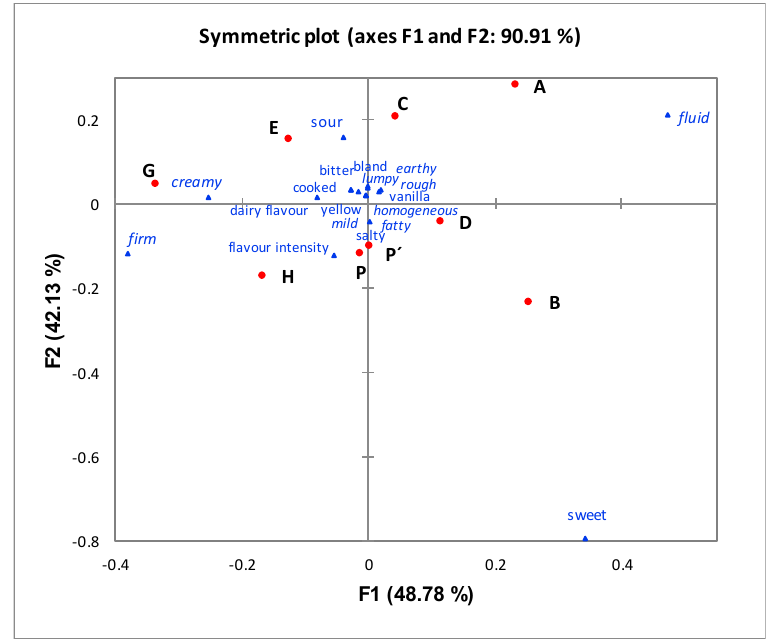
Figure 1. Representation of the samples and attributes in the first two factors of the correspondence analysis of sensory data obtained using Pivot profile (PP). Texture attributes are shown in italics and flavour attributes in regular type.